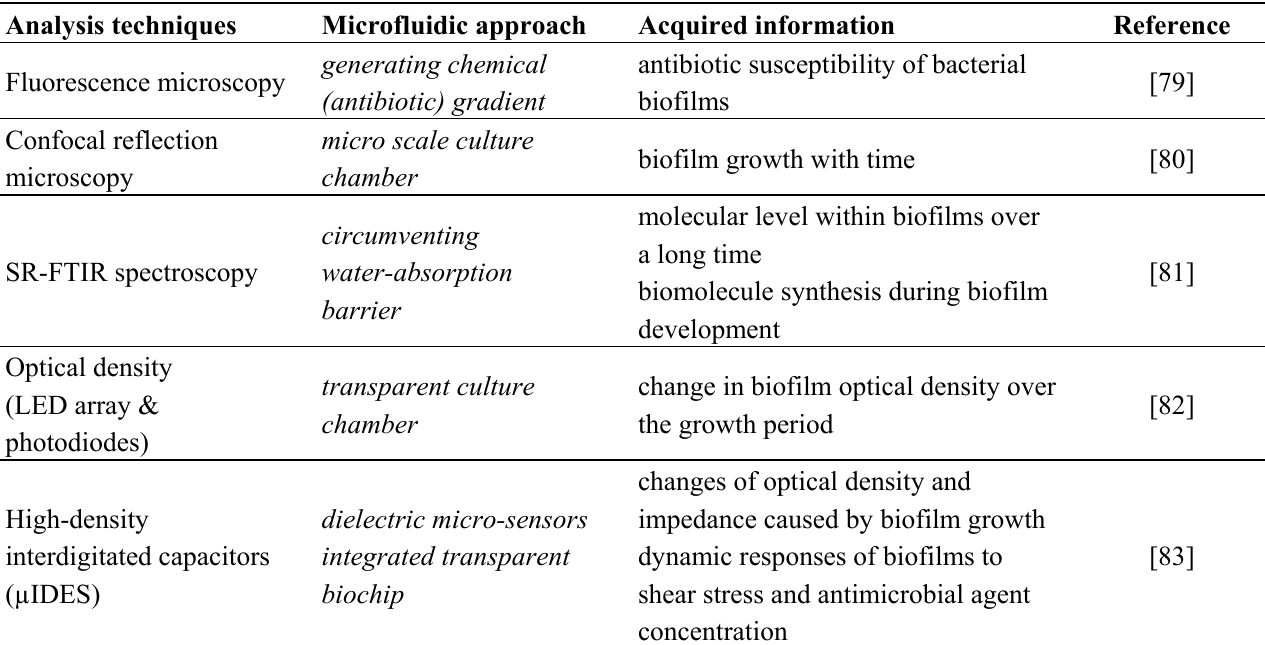
Table 2. Real-time methods to monitor biofilm